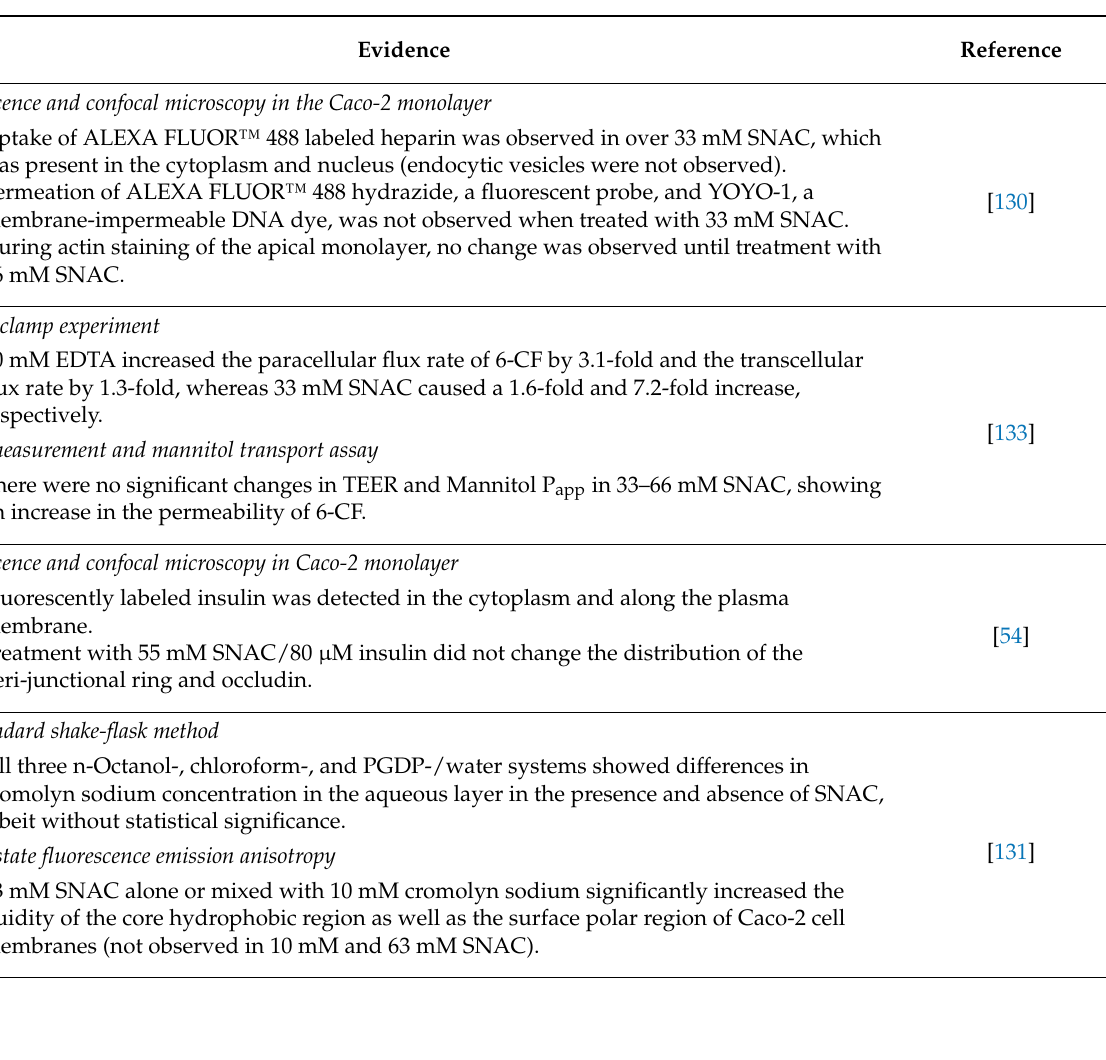
Table 5. Studies on the permeation enhancement mechanism of